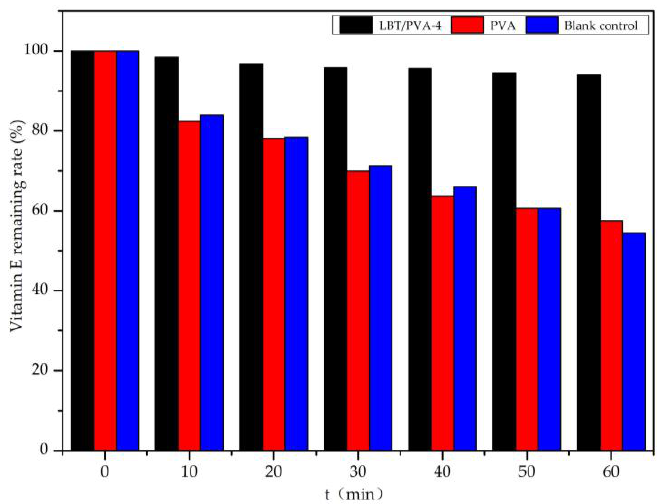
Figure 10. Protective effect of the LBT/PVA-4 membrane on Vitamin E.